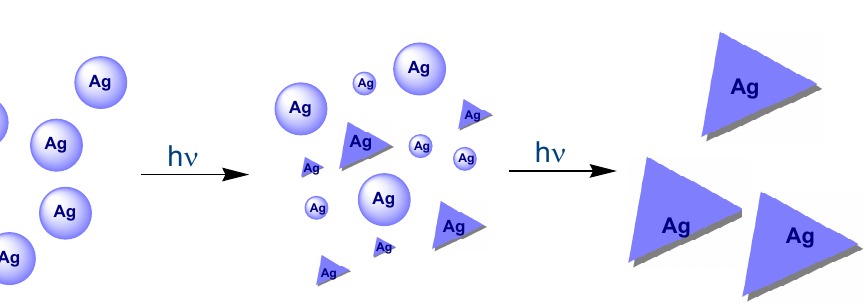
Figure 5. Ag nanoprism formation: irradiation of spherical silver nanoparticles gives rise to small silver nanoclusters and nanoprisms. The small silver nanoprisms then act as seeds and grow as the small spherical crystals are digested.